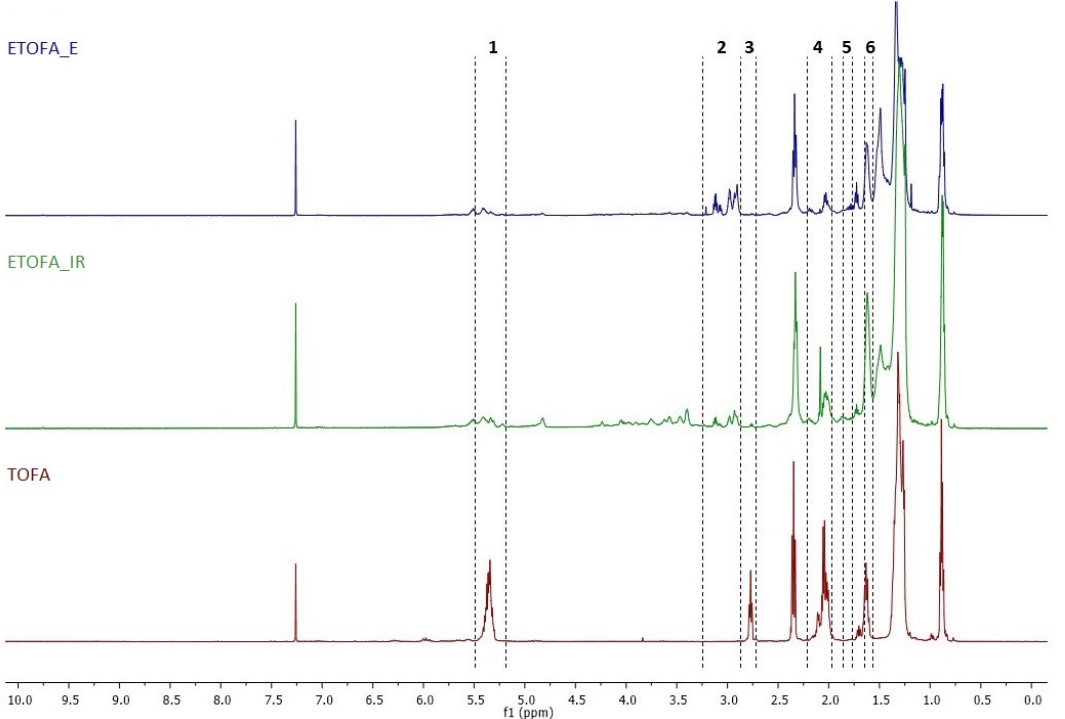
Figure 4. 1 H-NMR of TOFA and TOFA-catalysed epoxidation by ion-exchange resin (ETOFA_IR) and TOFA-catalysed epoxidation by lipase catalyst Novozym ® 435 (ETOFA_E) (500 MHz, CDCl 3 ). Abbreviations: 1—protons of double bond; 2—protons of oxirane moiety; 3—protons of bis -allylic position; 4—protons of allylic position; 5—CH 2 protons of oxiran-2-yl moiety; 6—CH 2 protons of bis- (oxiran-2-yl) moiety.